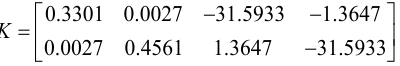
Figure 7a. Active